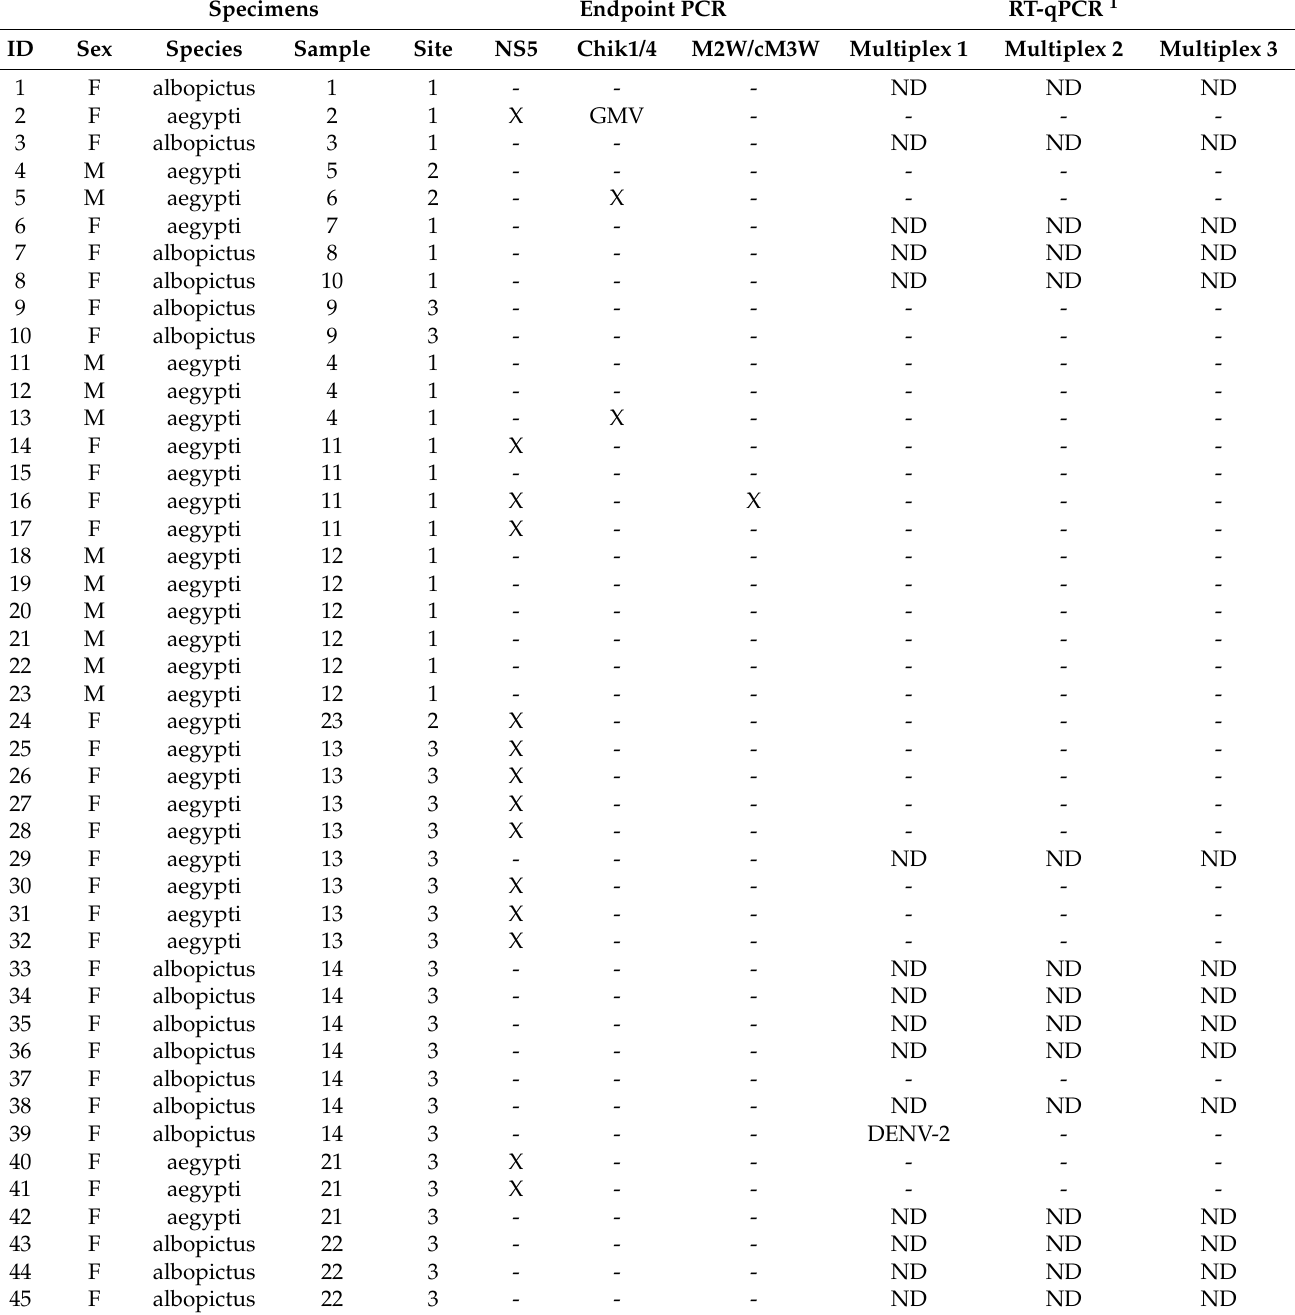
Table 1. Results of virus RNA testing of Aedes ( Stegomyia ) spp. in endpoint PCR and RT-qPCR